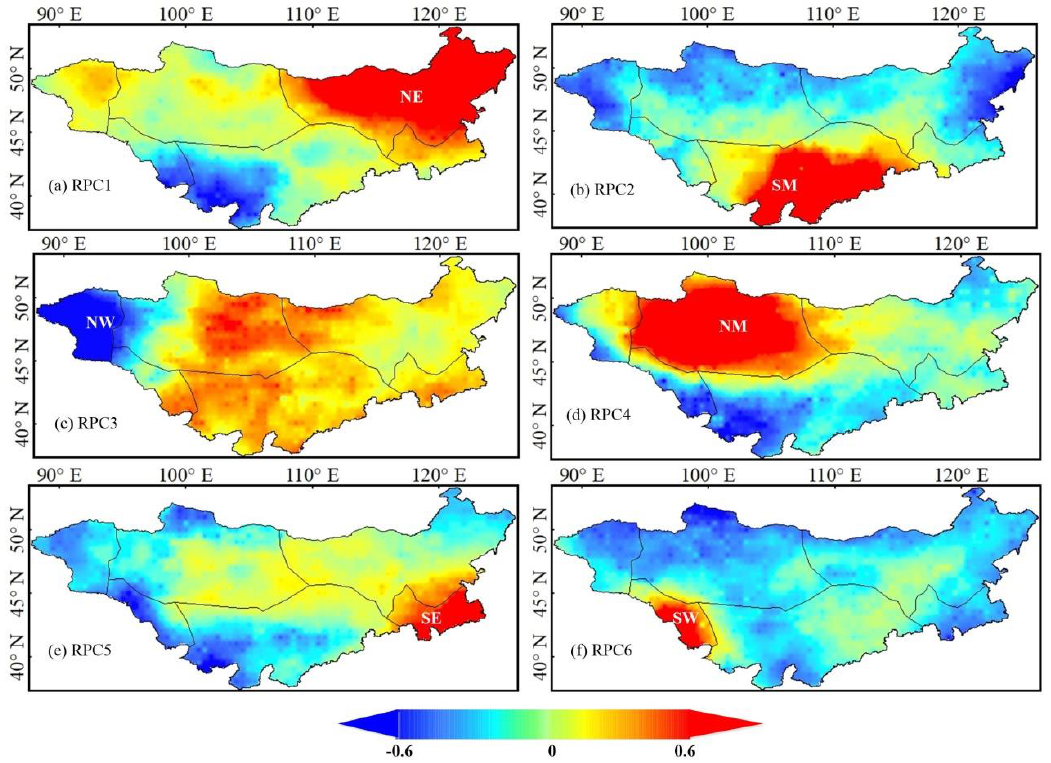
Figure 3. The sub-regional division based on the first six Varimax rotated components generated by PCA of the scPDSI. ( a ) RPC1, ( b ) RPC2, ( c ) RPC3, ( d ) RPC4, ( e ) RPC5, ( f ) RPC6